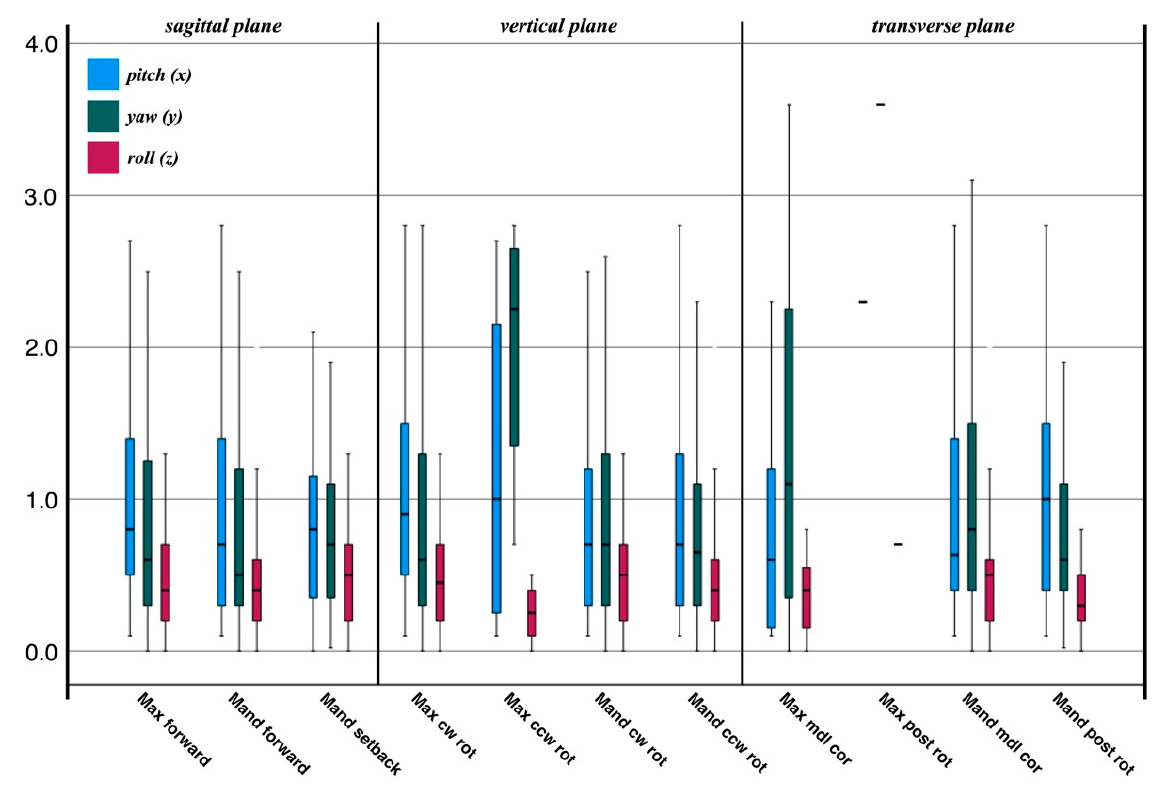
Figure 3. Rotation error around the mediolateral (pitch), superoinferior (yaw), and anteroposterior (roll) axes between virtual planning and postoperative outcome. The smallest errors are seen for rotational movements around the anteroposterior (z-) axis. Abbreviations: cw, clockwise; rot, rotation; ccw, counterclockwise; mdl, midline; cor, correction; post, posterior.